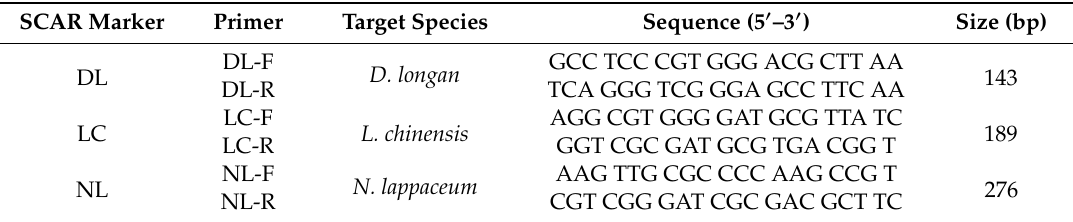
Table 2. Primer information for the singleplex and multiplex PCR